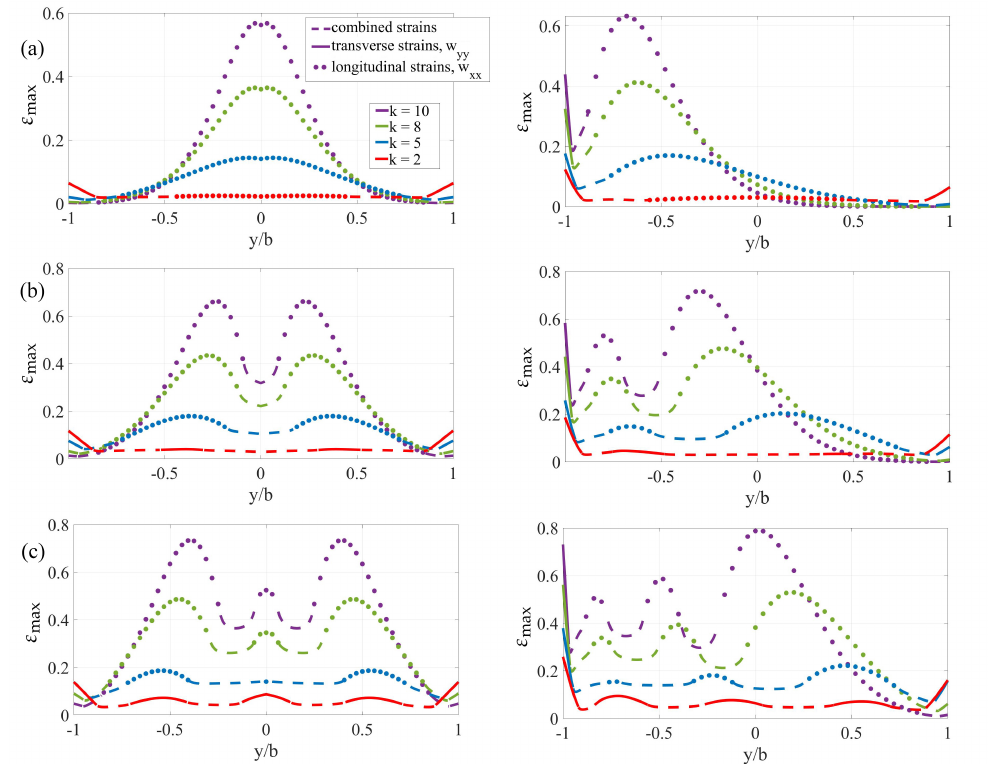
Figure 8. The scaled maximum strains ε max ( y ) in the hydroelastic wave along the phase for the first three modes for different values of k (see legend) and with h 0 = 0.0025 m. The results for Case 1 are shown on the left of the figure, for Case 2—on the right. The longitudinal strains are shown by dotted line (markers), transverse strains—by the solid line, combined strains—by the dashed line. The scale is A / ( 2 b 2 ) . Here, ( a )—first mode, ( b )—second and ( c )—third